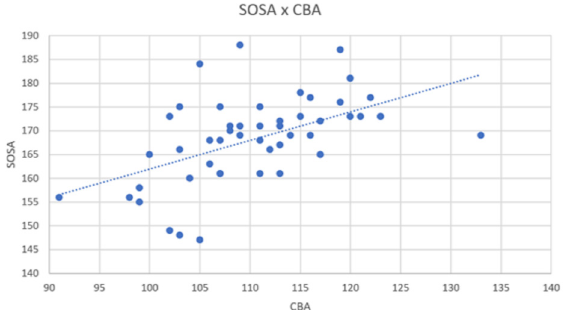
Figure 3. Correlation between cranial base angle (CBA) and sphenooccipital synchondrosis angle. (SOSA) R=0.51;